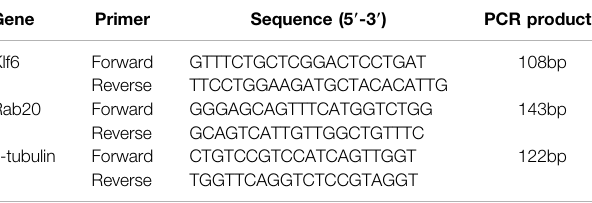
TABLE 1 | mRNA-speci fi c primers of key